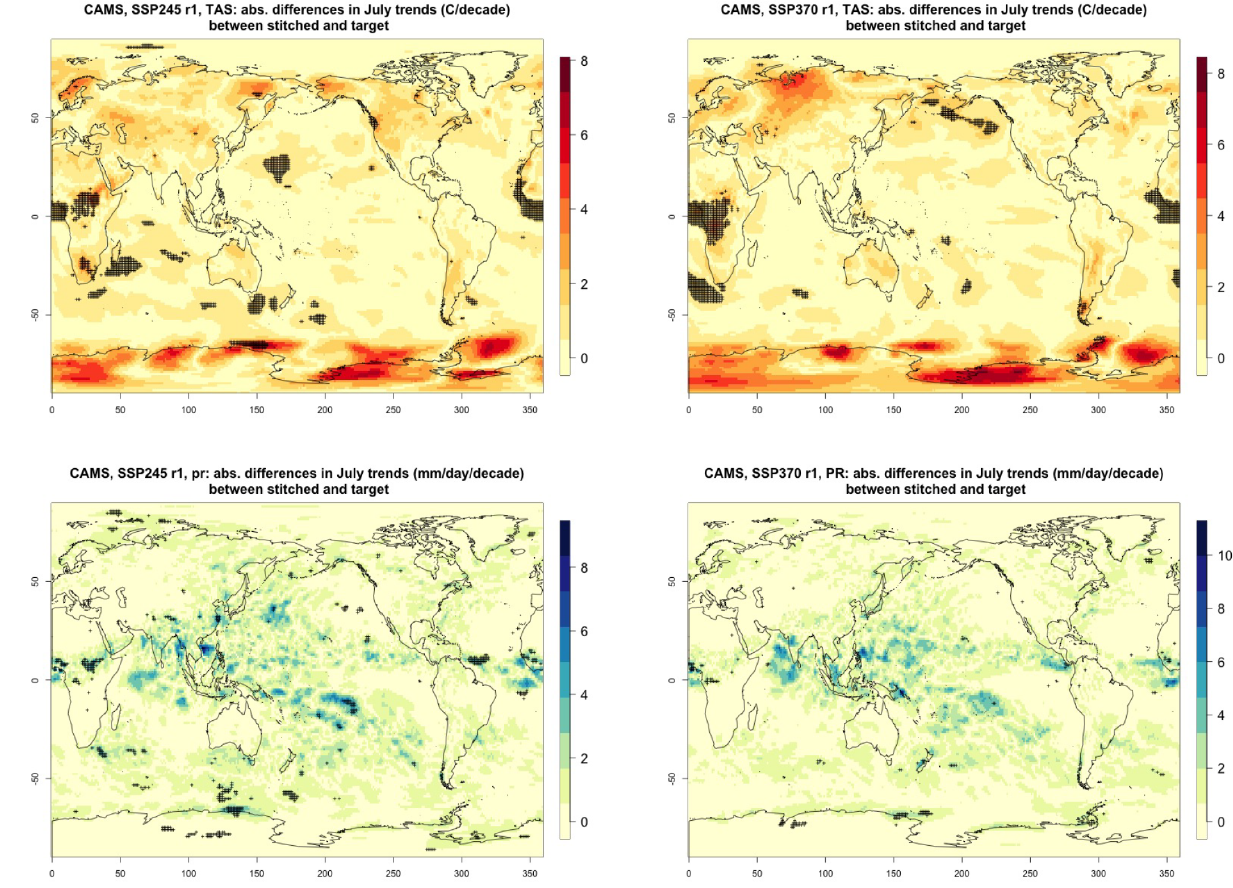
Figure C5. Absolute difference in decadal trends of July temperature (TAS) and precipitation (PR) between stitched and target realizations. The value of the difference is expressed by the color scale, and we marked as significant with black crosses those locations where the 95% confidence intervals of the trends computed from target and stitched time series do not overlap, indicating statistically significant differences. Emulation of CAMS, July time series over 2015–2100, for SSP2-4.5 and SSP3-7.0.